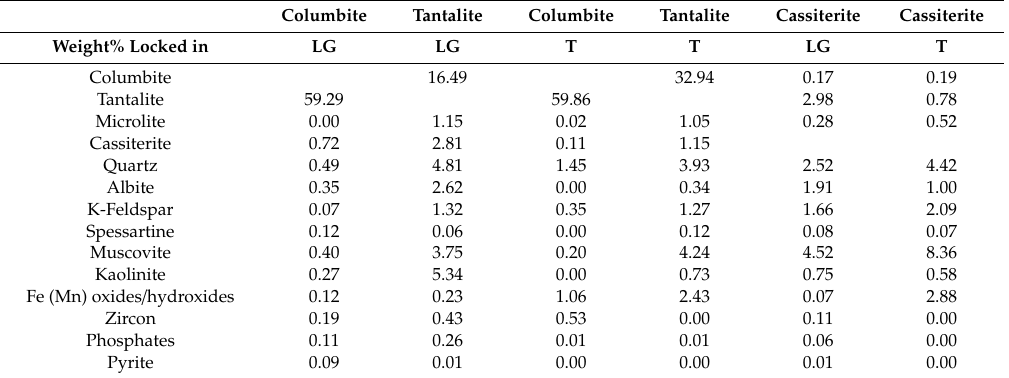
Table 4. Mineral associations (normalized wt%) of columbite, tantalite, and cassiterite in binary particles from Penouta outcropping leucogranite (LG) and tailings (T), as determined by mineral liberation analysis. Columbite Tantalite Columbite Tantalite Cassiterite Cassiterite Weight% Locked in